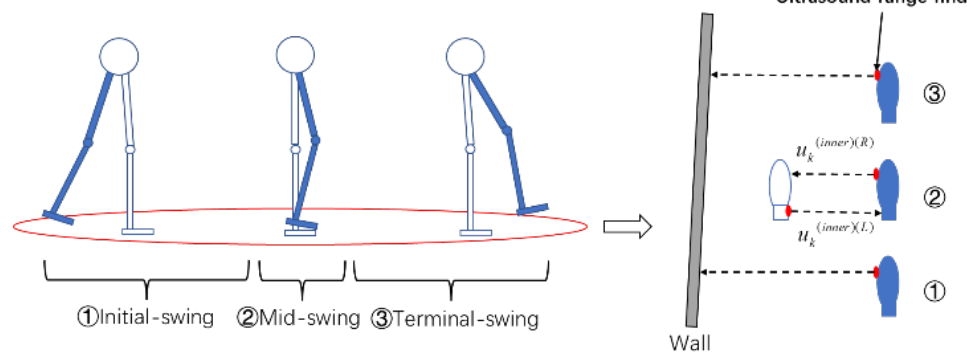
Figure 2. Schematic of right foot swing and inner ultrasound sensor scanning